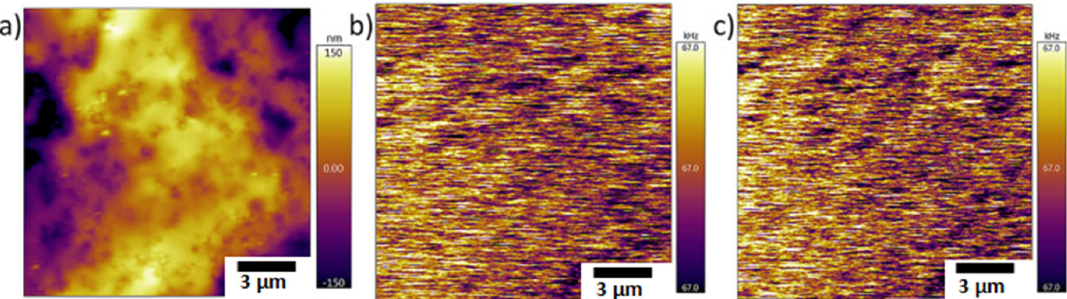
Figure 16. Magnetic force microscopy (MFM) images of pure gelatin films ( a ) topographical image; ( b ) frequency image at 0 Tl ( c ) frequency image at 0.47 T; both frequency images are identical indicating no response to external magnetic field [228]. (Reprinted with permission from Marín et al., 2018.)